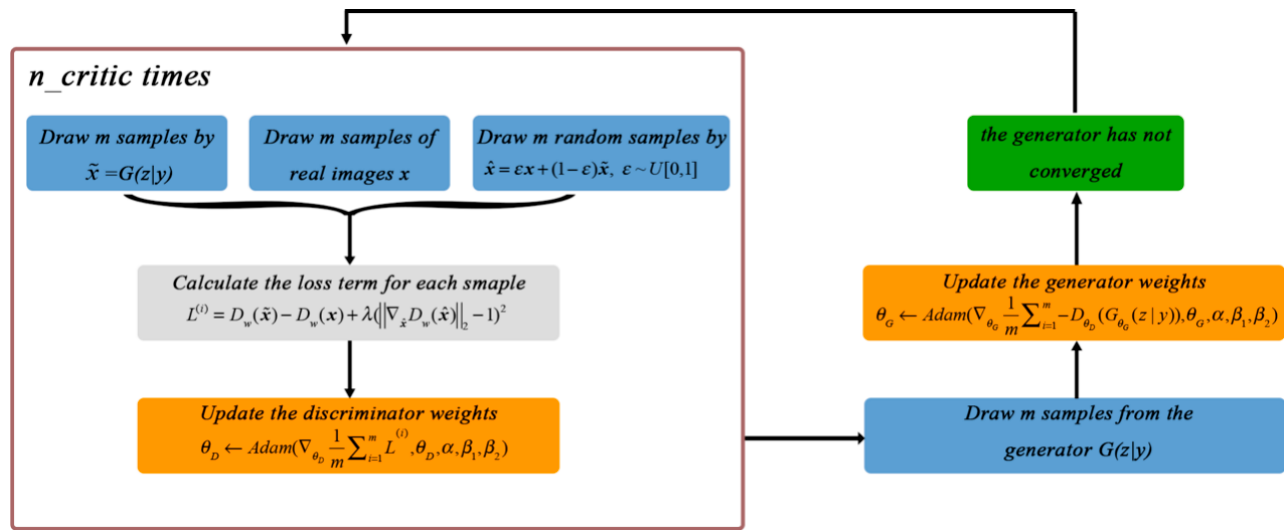
assignment of the hyperparameters was as follows: α = 0.0001, β 1 = 0, β 2 = 0.9.